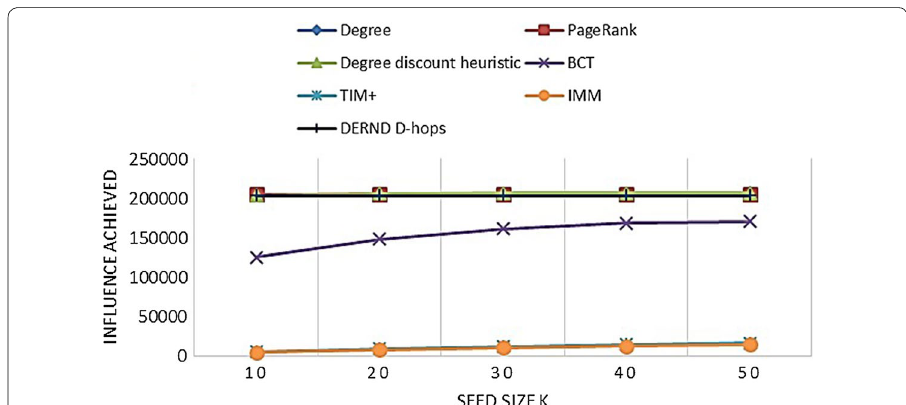
UERND D-hops IMM +